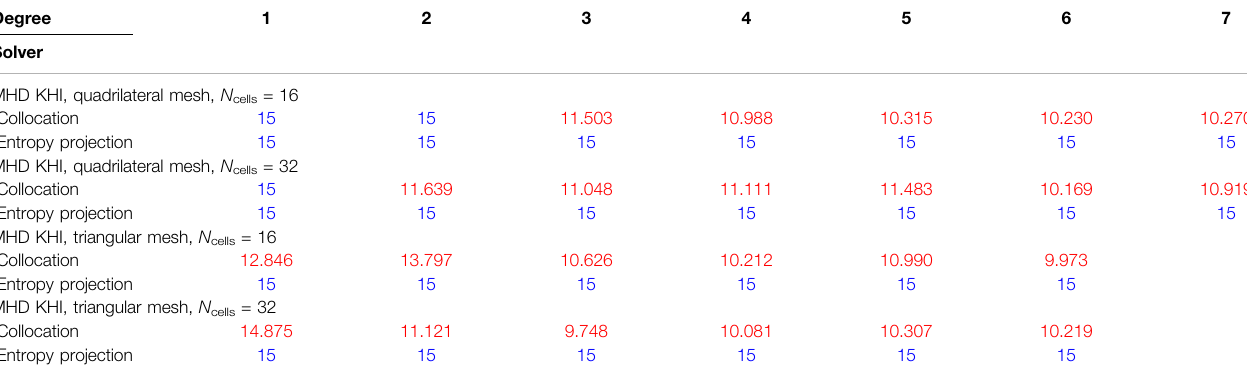
TABLE 5 | End time for simulations of the magnetized Kelvin-Helmholtz instability on quadrilateral and triangular meshes. On quadrilateral meshes, “ collocation ” refers to a nodalDGSEMdiscretization,while “ entropyprojection ” referstoamethodbasedonGaussnodes.Ontriangularmeshes, “ collocation ” referstonodalSBPdiscretization, while “ entropy projection ” refers to a modal entropy stable DG method.